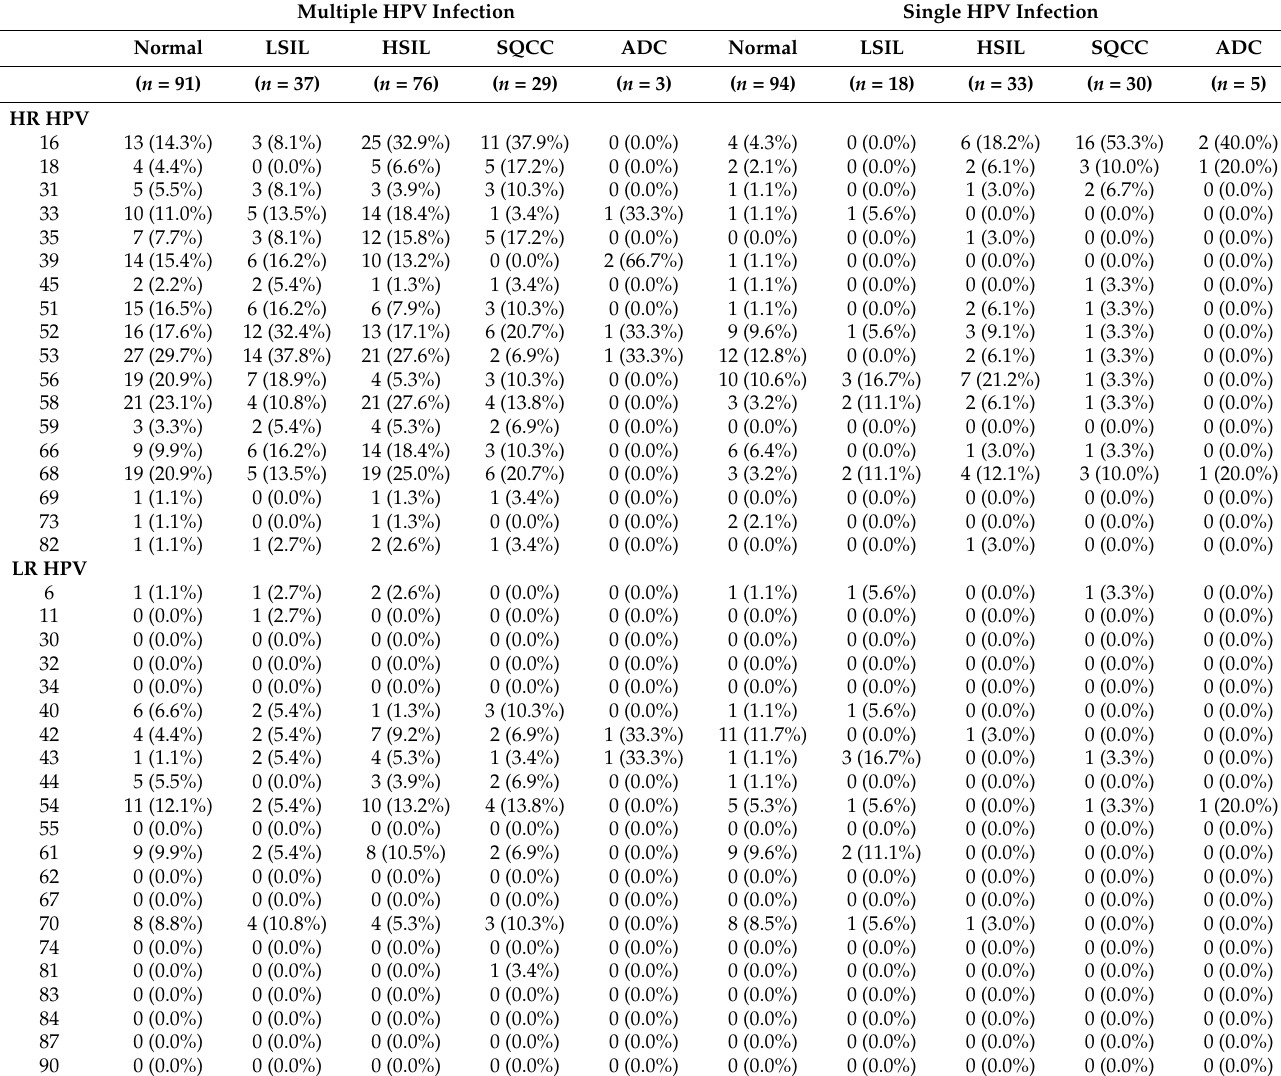
Table 3. Association between histologic diagnosis and HPV genotypes (single and multiple HPV